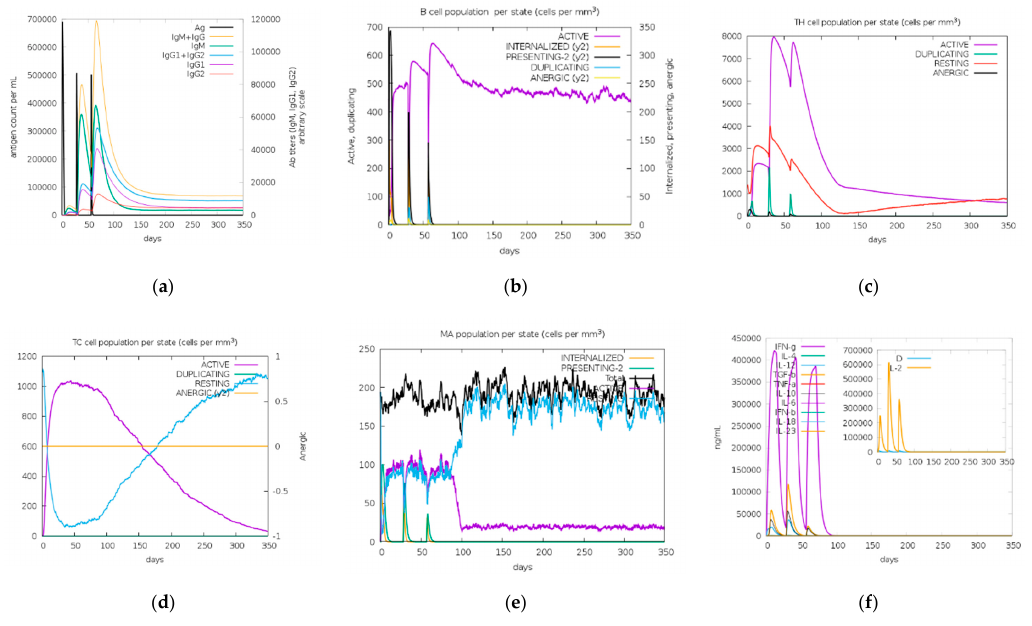
Figure 8. In silico immune simulation of EIJK-61453 vaccine using C-ImmSim server. Antigen and immunoglobulins ( a ), B cell population ( b ), TH cell population ( c ), TC cell population ( d ), macrophage population ( e ), production of cytokine and interleukins with Simpson index ( f ).